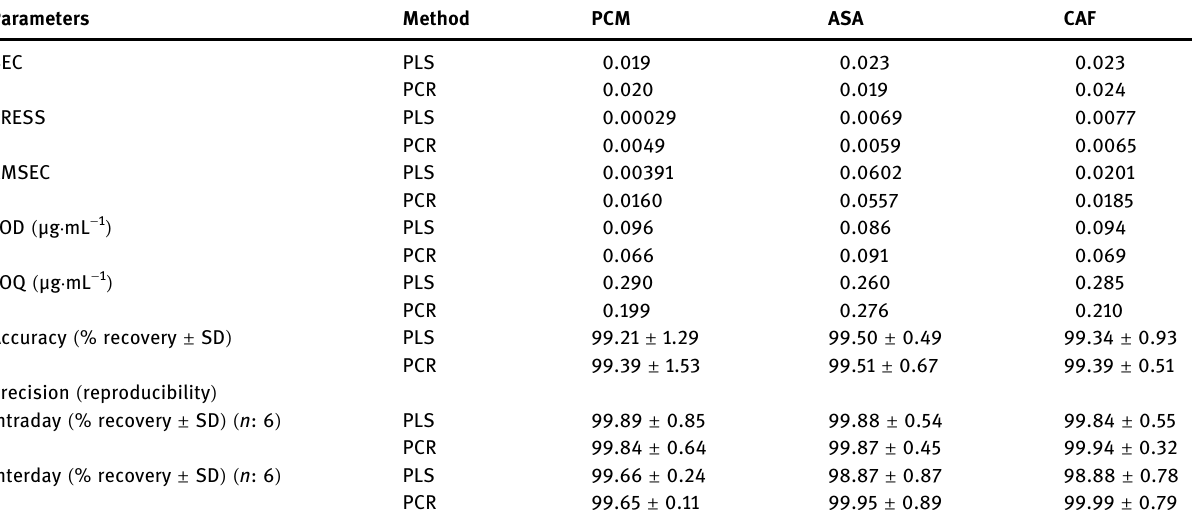
Table 5: Statistical parameter values for calibrating step - simultaneous ASA, PCM, and CAF determinations using PLS and PCR techniques Parameters